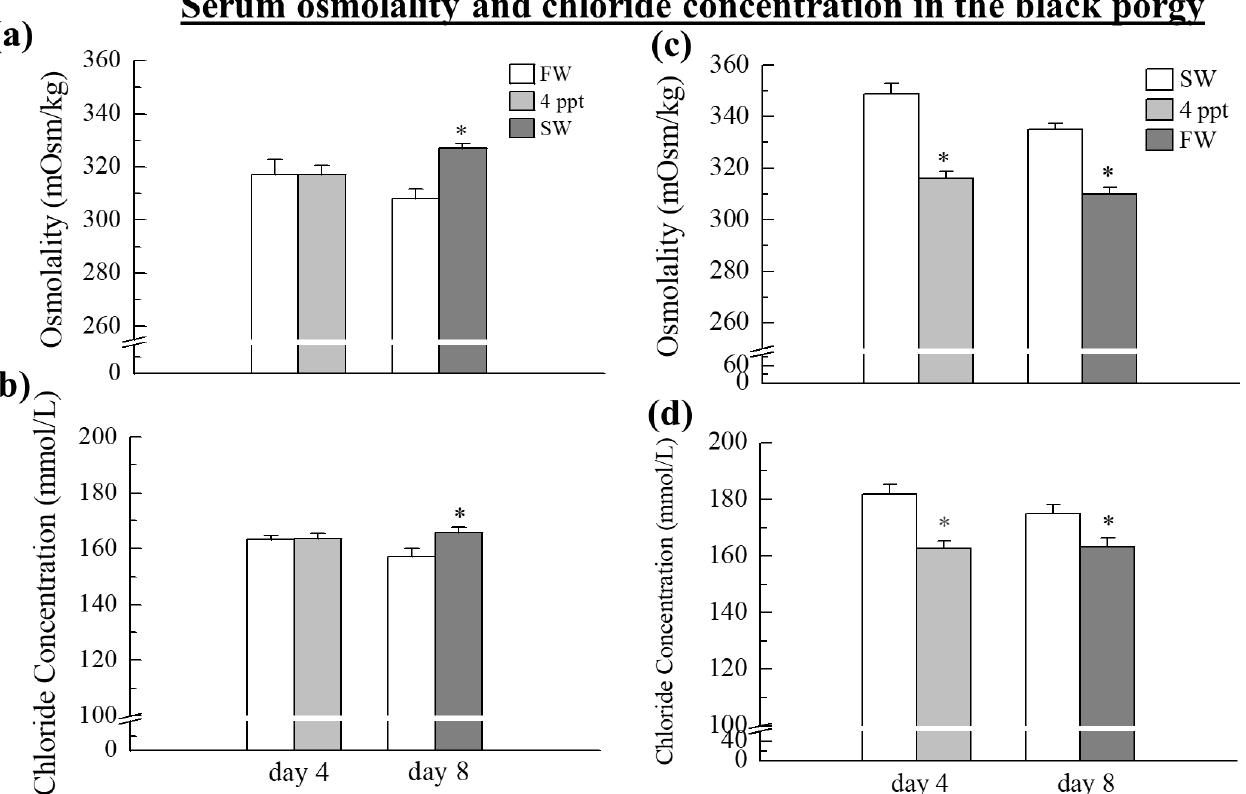
Figure 1. Analysis of the serum osmolality ( a and c ) and chloride concentrations ( b and d ) in black porgy on day 4 and 8 (n = 9, in each group). The results are expressed as the mean ± SEM (standard error of the mean). Asterisks (*) indicate significant differences ( p < 0.05) between control and treated groups.